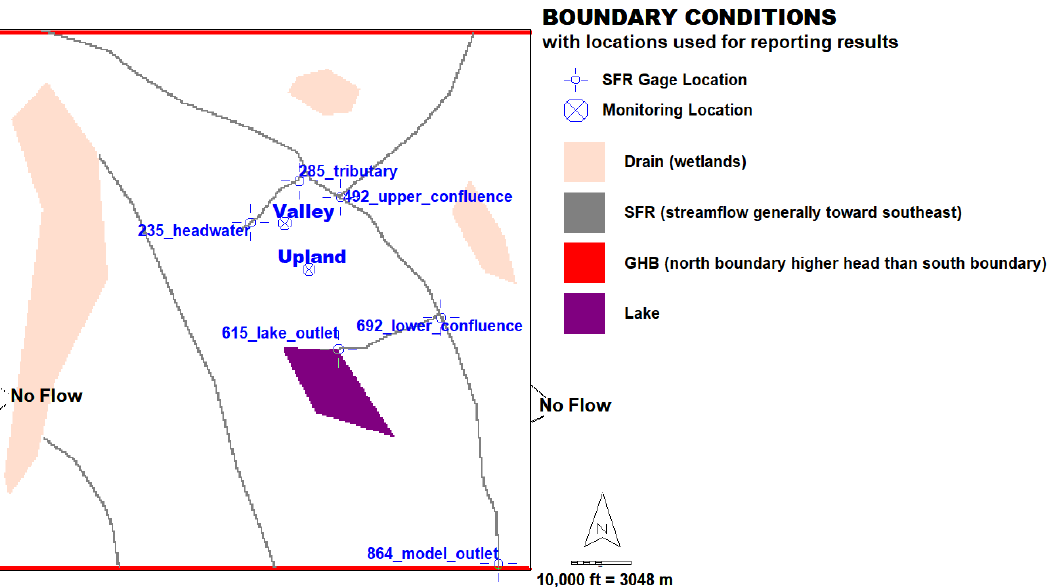
Figure 3. Synthetic model setup showing domain and boundary conditions, as well as locations for monitoring temperature results. Cross-sections are shown in Figure 4. [SFR: Stream Flow Routing; GHB: General Head Boundary].